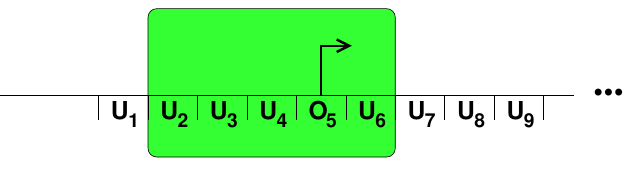
Fig. 1. Schematic diagram illustrating the relationship between the polymerase active site and the template strand states. The polymerase is represented by the green rounded rectangle, and its active site by the hooked arrow. Here, the active site occupies site 5, while all other sites are “unoccupied” in the sense discussed in the text. This illustration is not intended to realistically portray the geometry of the transcription complex. In particular, a much longer stretch of DNA passes through the polymerase than is shown